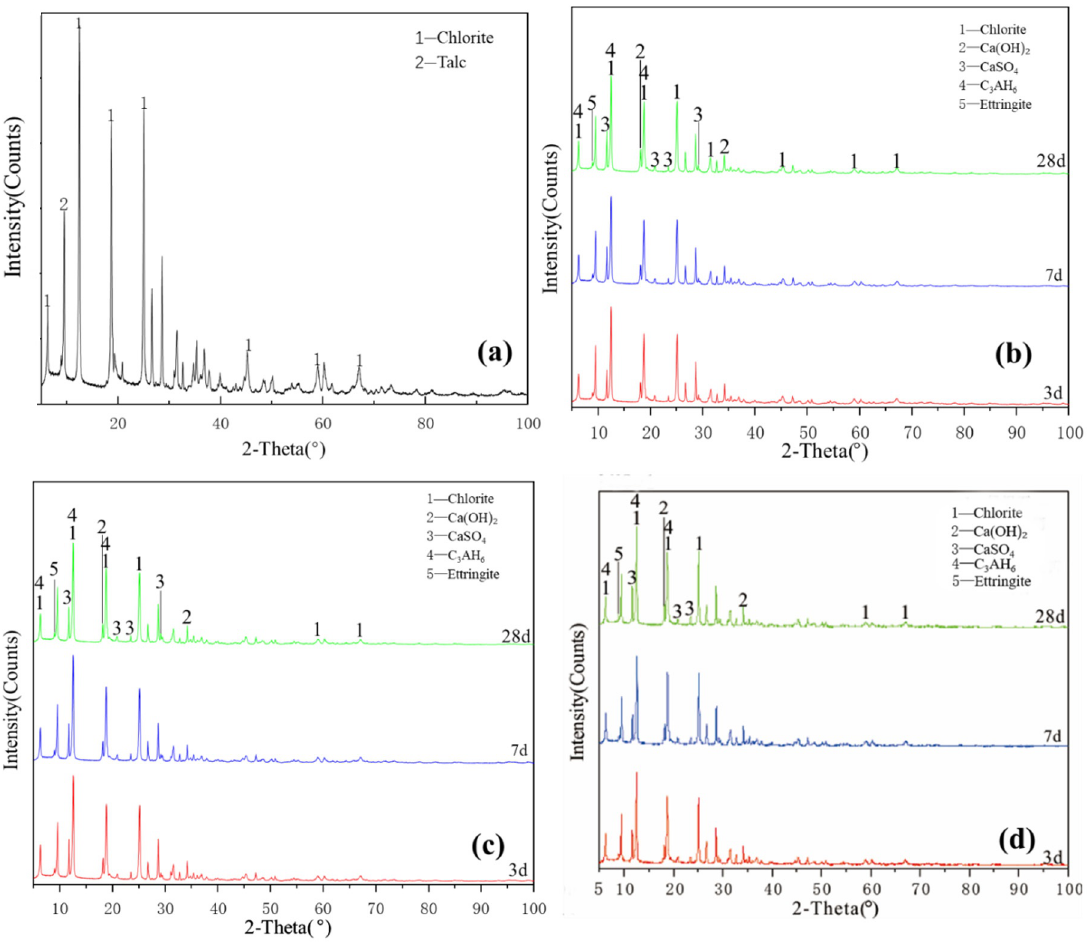
Figure 5. XRD patterns of chlorite: ( a ) raw material, ( b ) 3-, 7- and 28-day curing age Y0, ( c ) 3-, 7- and 28-day curing age Y1, ( d ) 3-, 7- and 28-day curing age Y1-2.